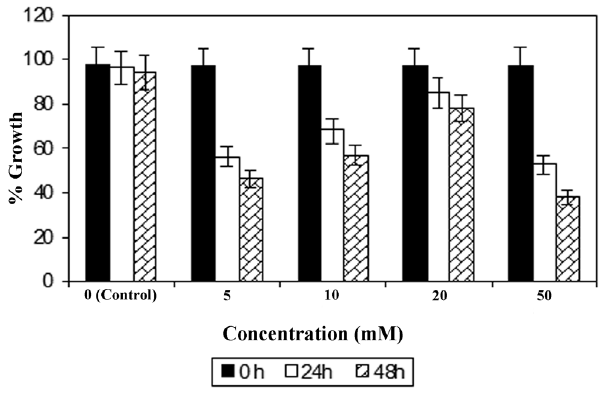
Figure 1. Concentrations of C-phycocyanin in the presence of oxalate in MDCK cells. Different concentrations of CP (5, 10, 20, 50 mM) in the presence of oxalate (0.1 mM) in MDCK cell line showing the effective dosage of CP at 20 mM concentration at 24 and 48